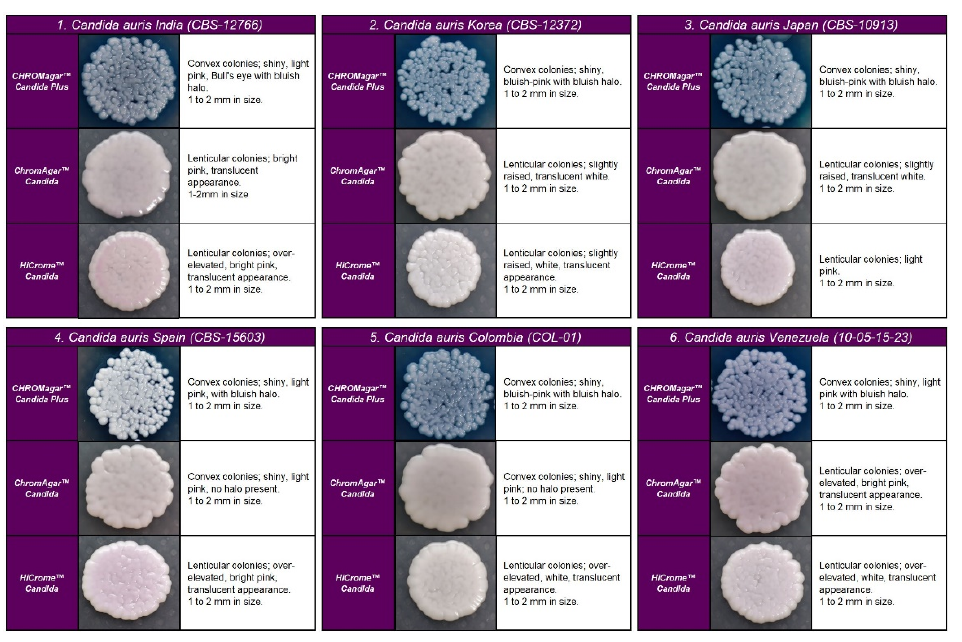
Figure 2. Appearance of colonies of most pathogenic Candida species on CHROMagar™ Candida Plus medium, CHROMagar™ Candida medium, and HiCrome TM Candida after 48 h incubation at 35 °C. After 24 h incubation on CHROMagar Candida plus fluconazole, C. auris showed smooth, convex, shiny, and light pink colonies (colony size 0.7–3 mm). After 48 h, they acquired an egg yolk morphology (white periphery and purple center). Although C. auris, C. glabrata , or C. krusei showed a similar pink color at 48 h incubation, phenotypic differ- entiation was possible due to the same characteristics observed for C. krusei and C. glabrata on CHROMagar TM -Candida . All C. auris strains but COL-01 and CBS-10913 were able to grow (these two isolates were susceptible to fluconazole), while S. cerevisiae , C. albicans , and C. famata showed inhibition of growth in this fluconazole-supplemented medium ( Figures 2 and 3).